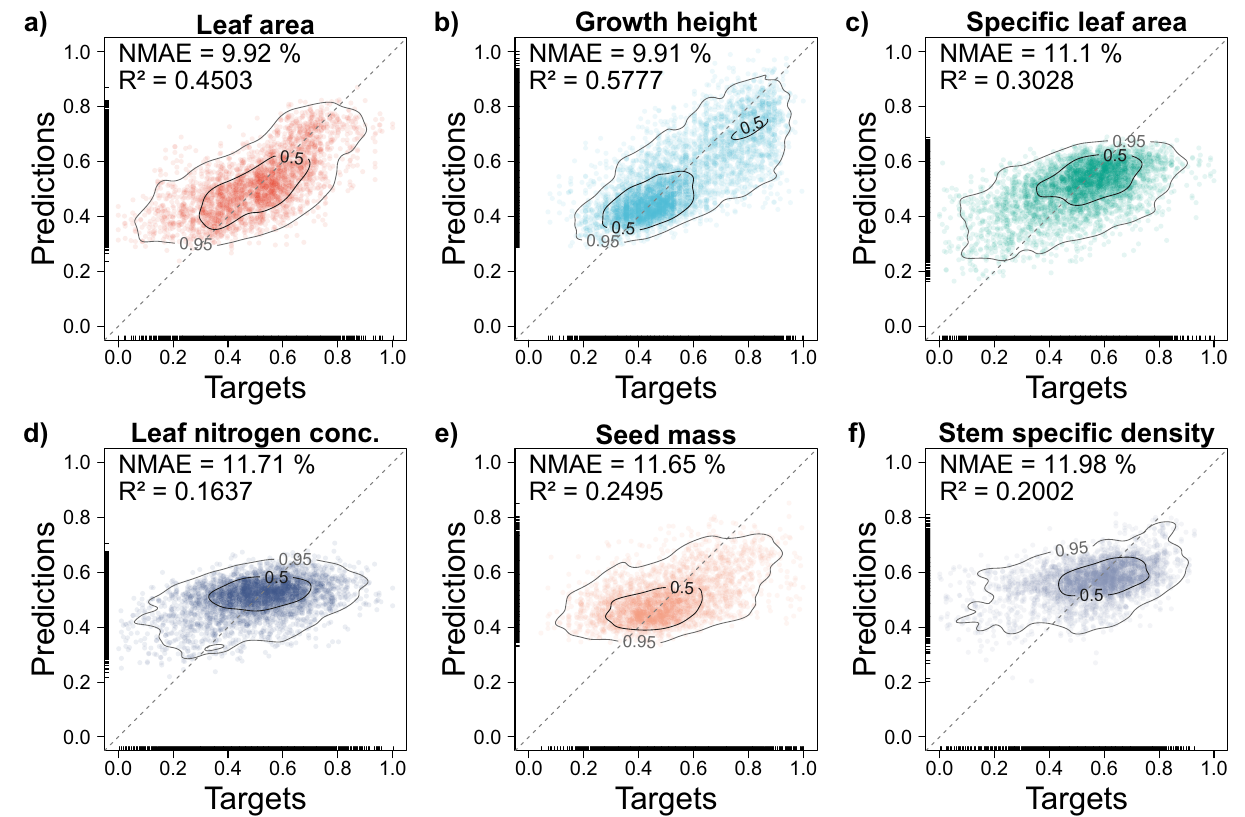
Figure 3. Distributions of predictions and targets of 3-fold cross-validation. a-f , All target-reference pairs (N = 3 × N test ) of Ensemble setup of 3-fold cross-validation for the six plant functional traits leaf area ( a ), growth height ( b ), specific leaf area ( c ), leaf nitrogen concentration ( d ), seed mass ( e ) and stem specific density ( f ). Dashed grey lines indicate the one-to-one line for reference. Contour lines indicate the bivariate occurrence probabilities (50% and 95%) computed by kernel density estimation using R 23 package ’ks’ (version 1.11.7) 24 .